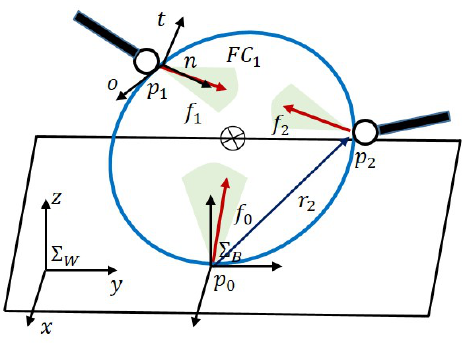
Figure 6. Object, EEFs, and